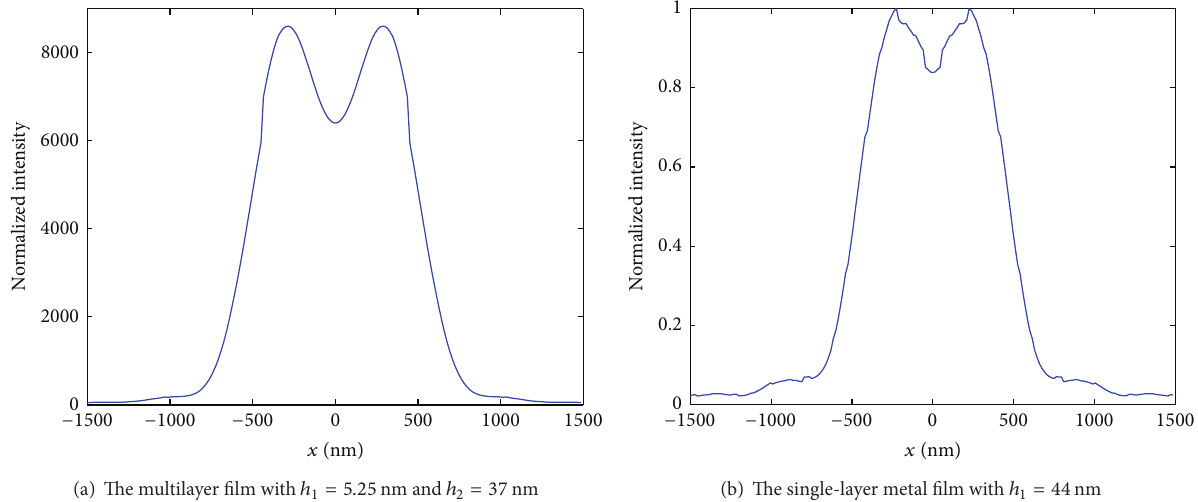
Figure 3: Normalized intensity of emission by a dipole along the 𝑥 direction in the focal plane of 𝑧 = 0 . space, the imaging space, and the space between the objective lens and the cover glass,